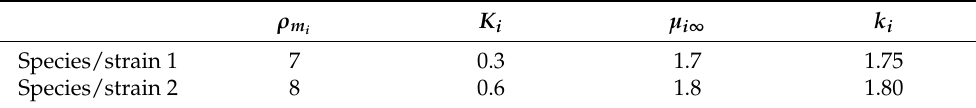
Table 1. The model parameters used in Section 5.